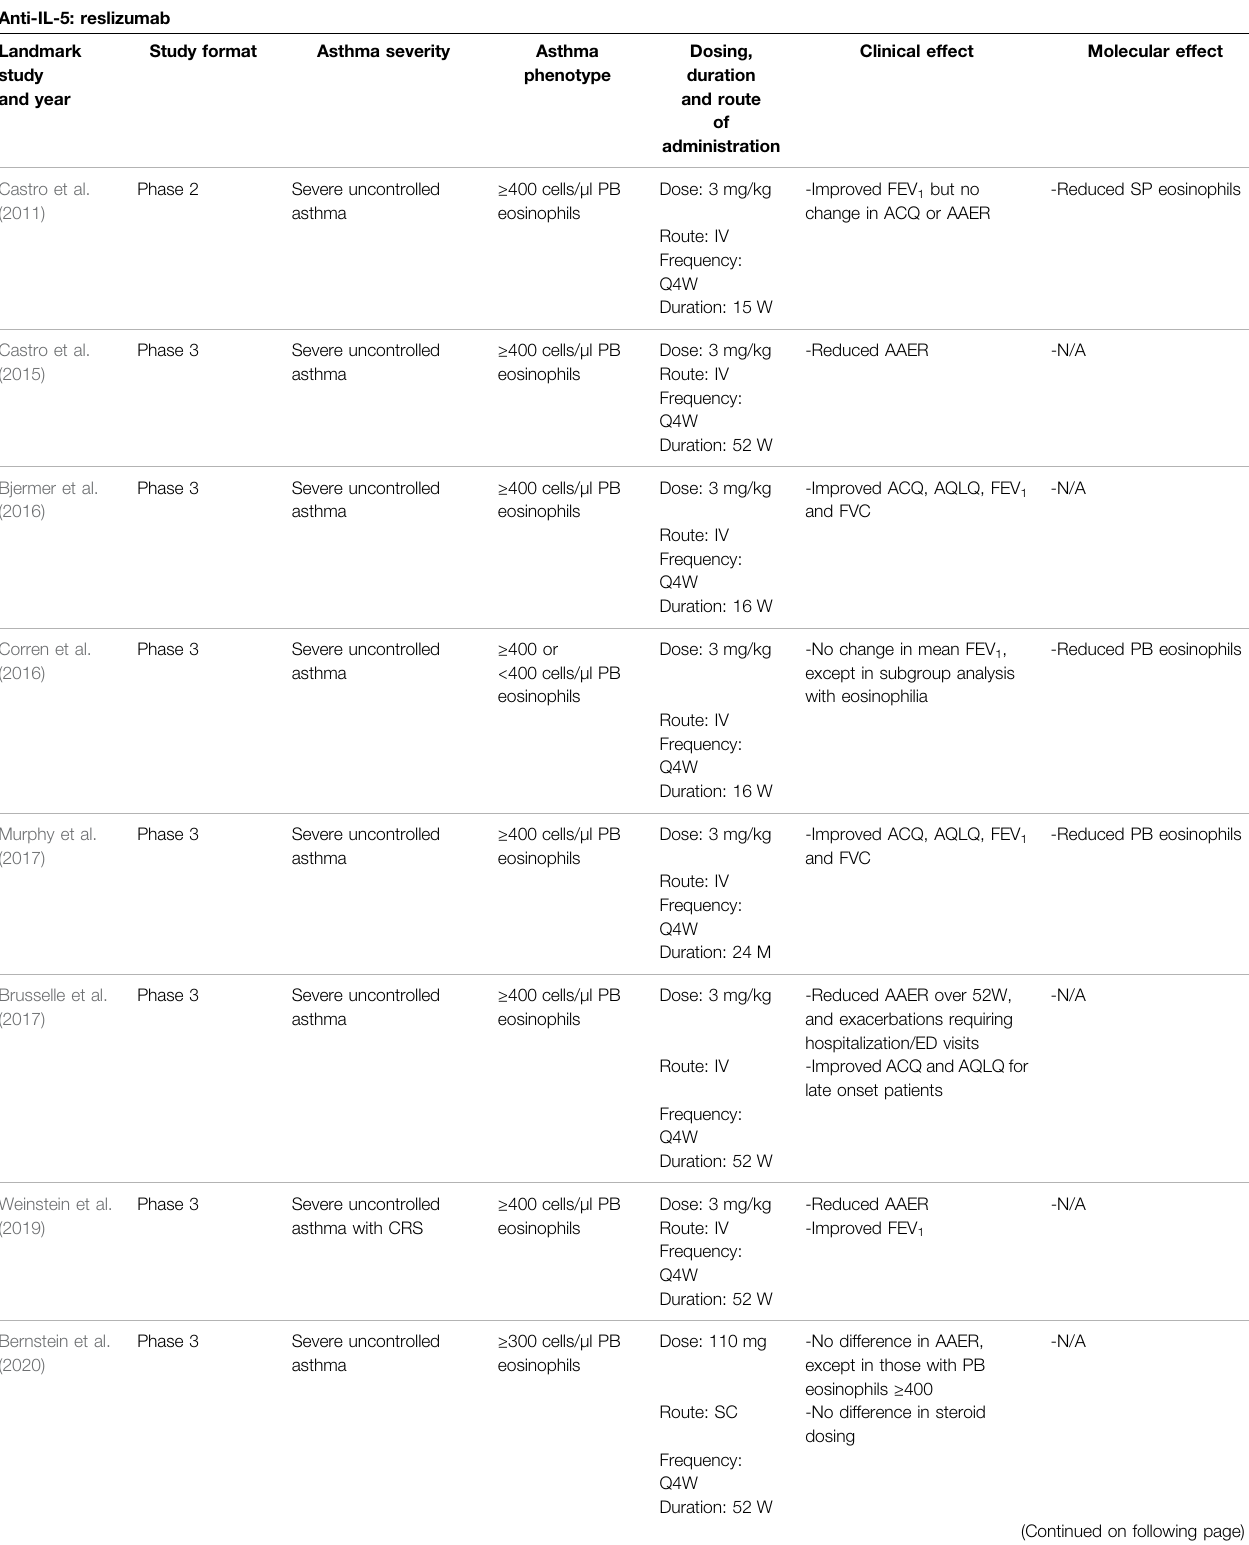
TABLE 3 | Summary of randomized clinical trials assessing reslizumab in severe